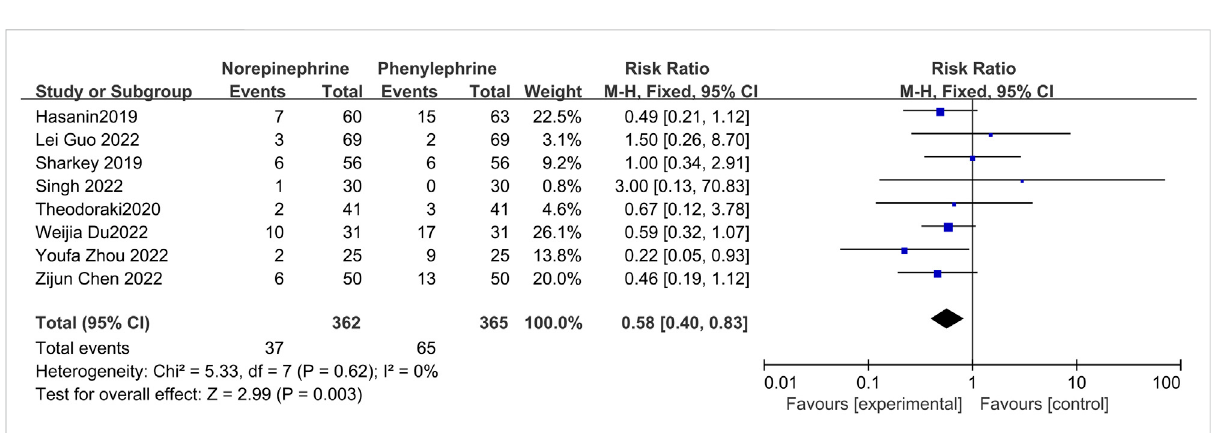
FIGURE 5 Forest plot of the incidence of reactive hypertension comparing norepinephrine with phenylephrine.